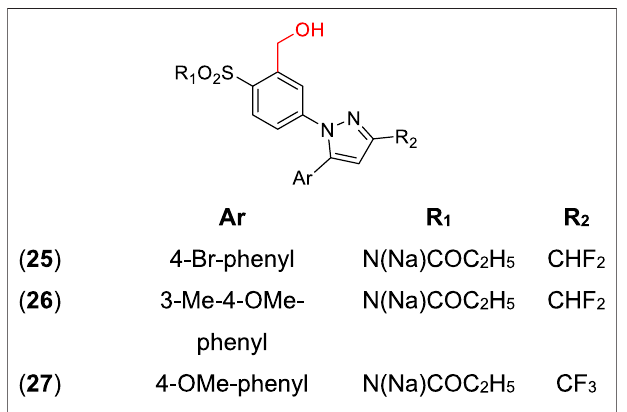
FIGURE 1 | Hydroxymethyl and sulfamoyl prodrugs ( 25 – 27 ) are potentially anti-in fl ammatory.